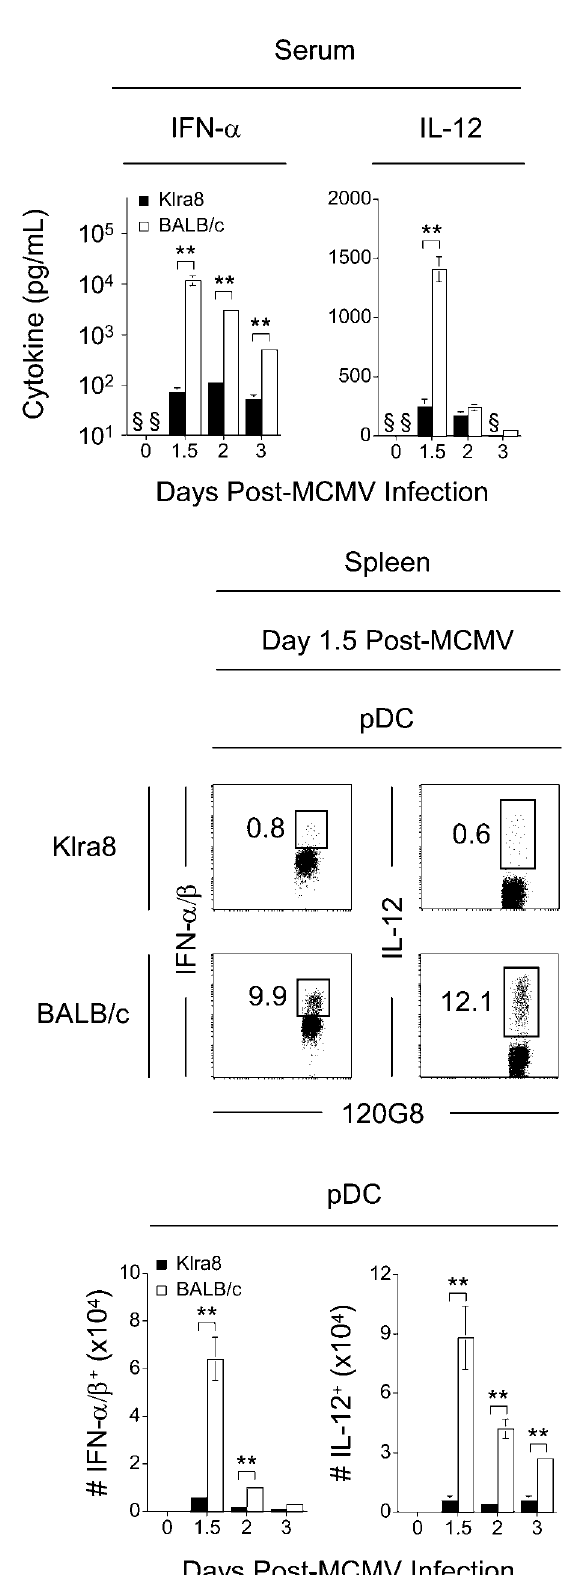
Figure 1. Decreased pDC Cytokine Production in the Presence of Ly49H/ m157-Mediated NK Cell Activation (A) Serum from Klra8 and BALB/c mice was collected on days 0, 1.5,